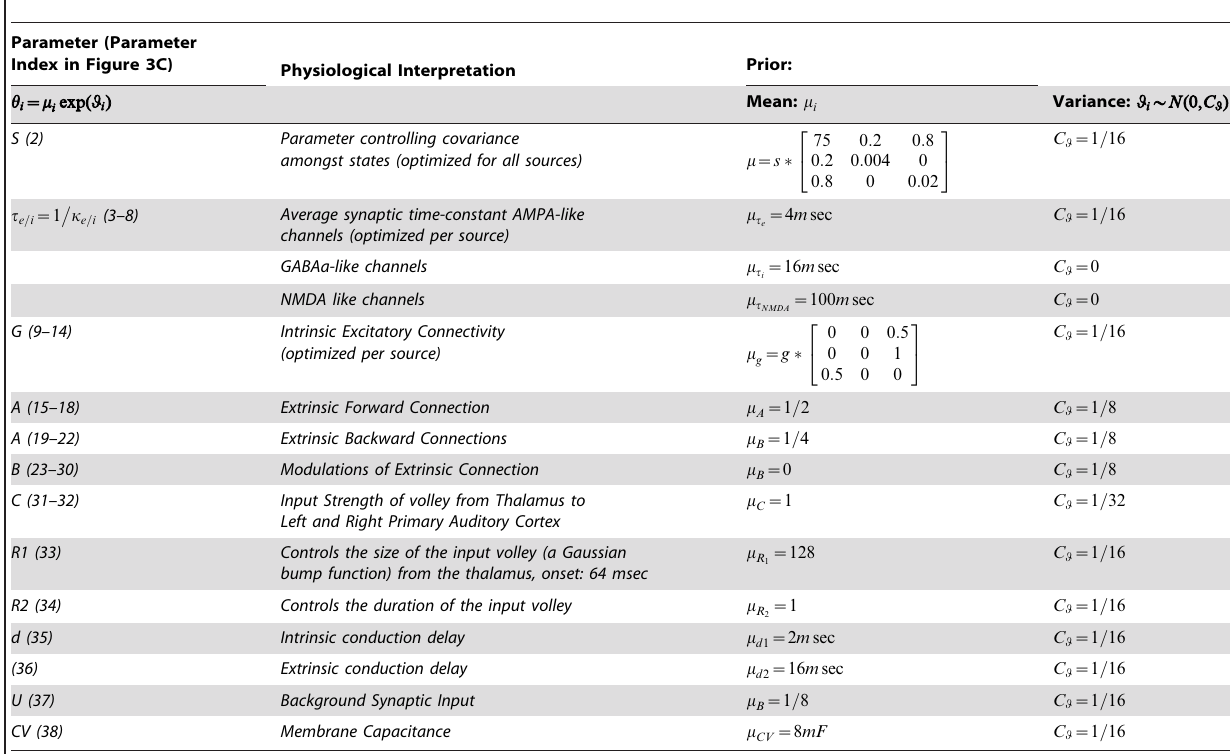
Table 1. Neuronal parameters of the DCM – description and prior values presented in Figure 3C.